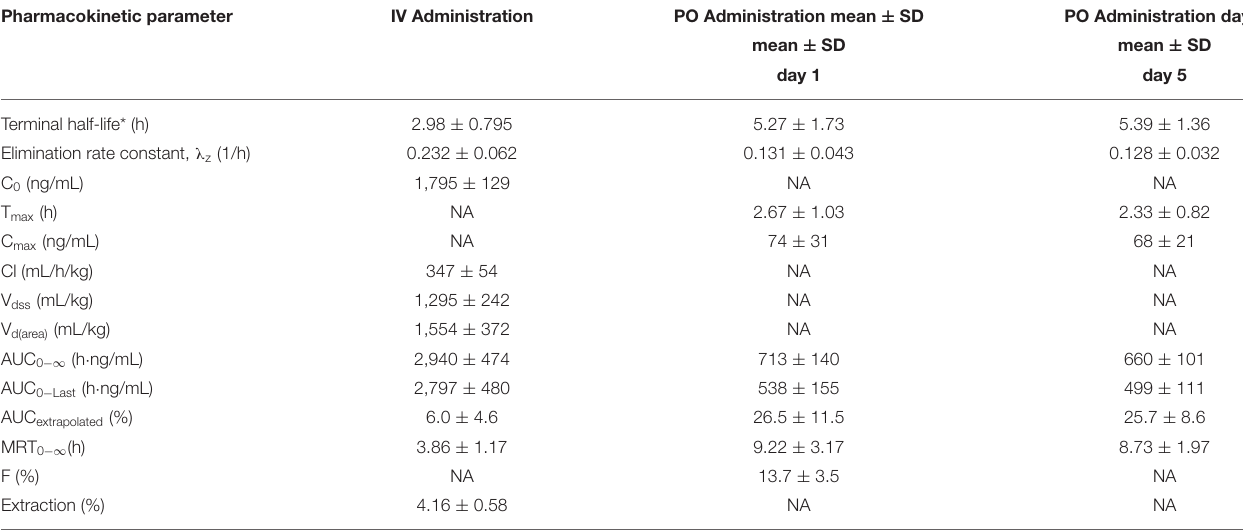
TABLE 1 | Pharmacokinetic parameters (mean ± SD) in alpacas on Day 1 and Day 5 after multi-dose oral administration of 2 mg/kg prednisolone ( n = 6) and IV administration of 1 mg/kg ( n = 4). Pharmacokinetic